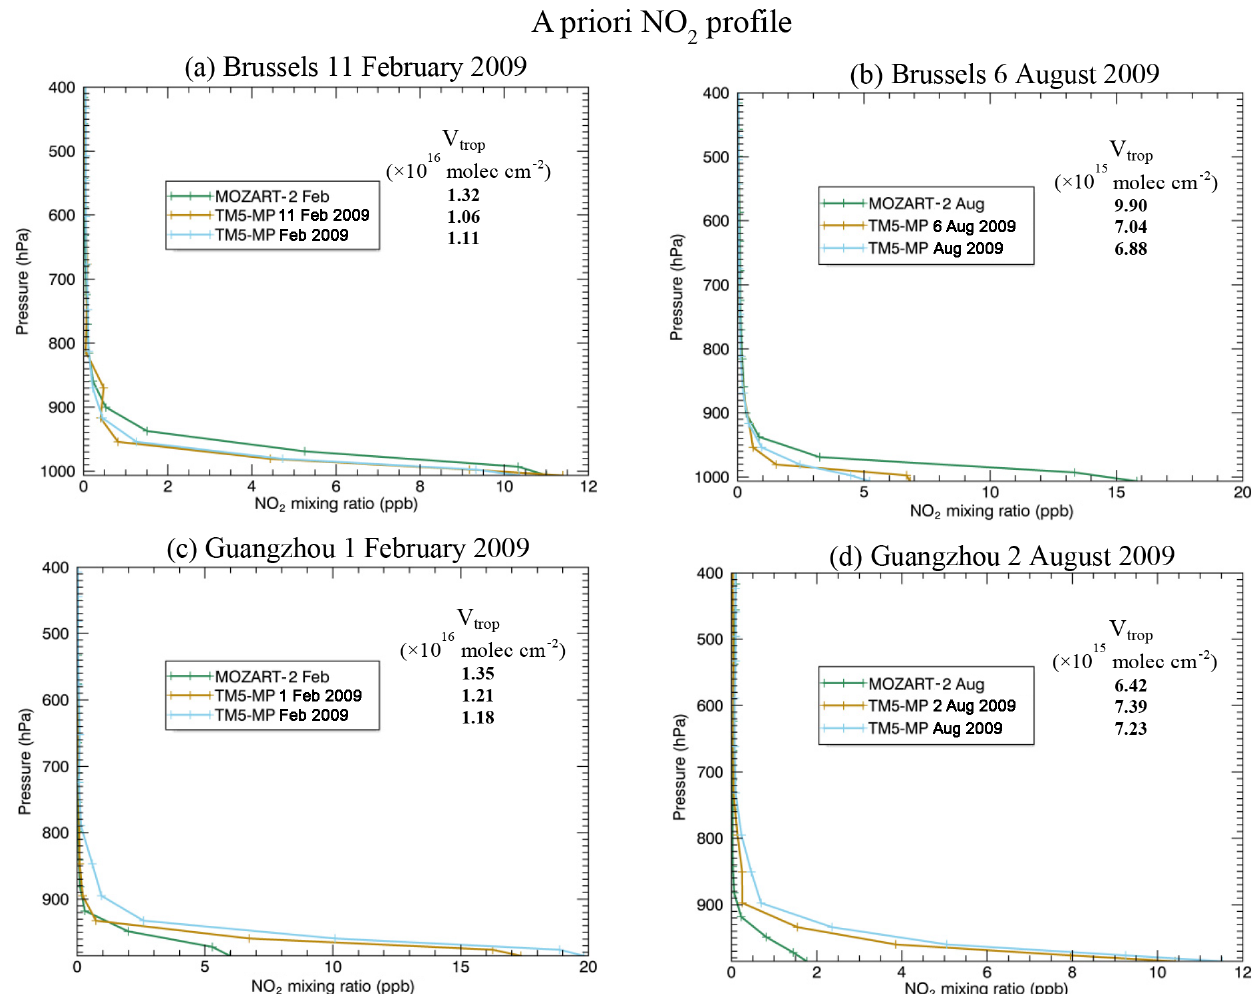
Figure 12. Examples of a priori NO 2 profiles for Brussels (a, b) and Guangzhou (c, d) on a given day in February (a, c) and August (b, d) 2009. Monthly profiles are shown for MOZART-2 (green), and daily profiles on the given days are shown for TM5-MP (brown) together with the monthly average profiles calculated for TM5-MP (blue). The tropospheric NO 2 columns retrieved using each a priori NO 2 profile are also